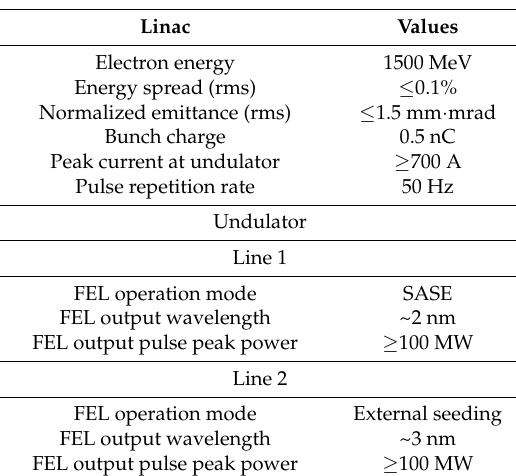
Table 5. Designed working parameters of the main linac for SXFEL-UF.